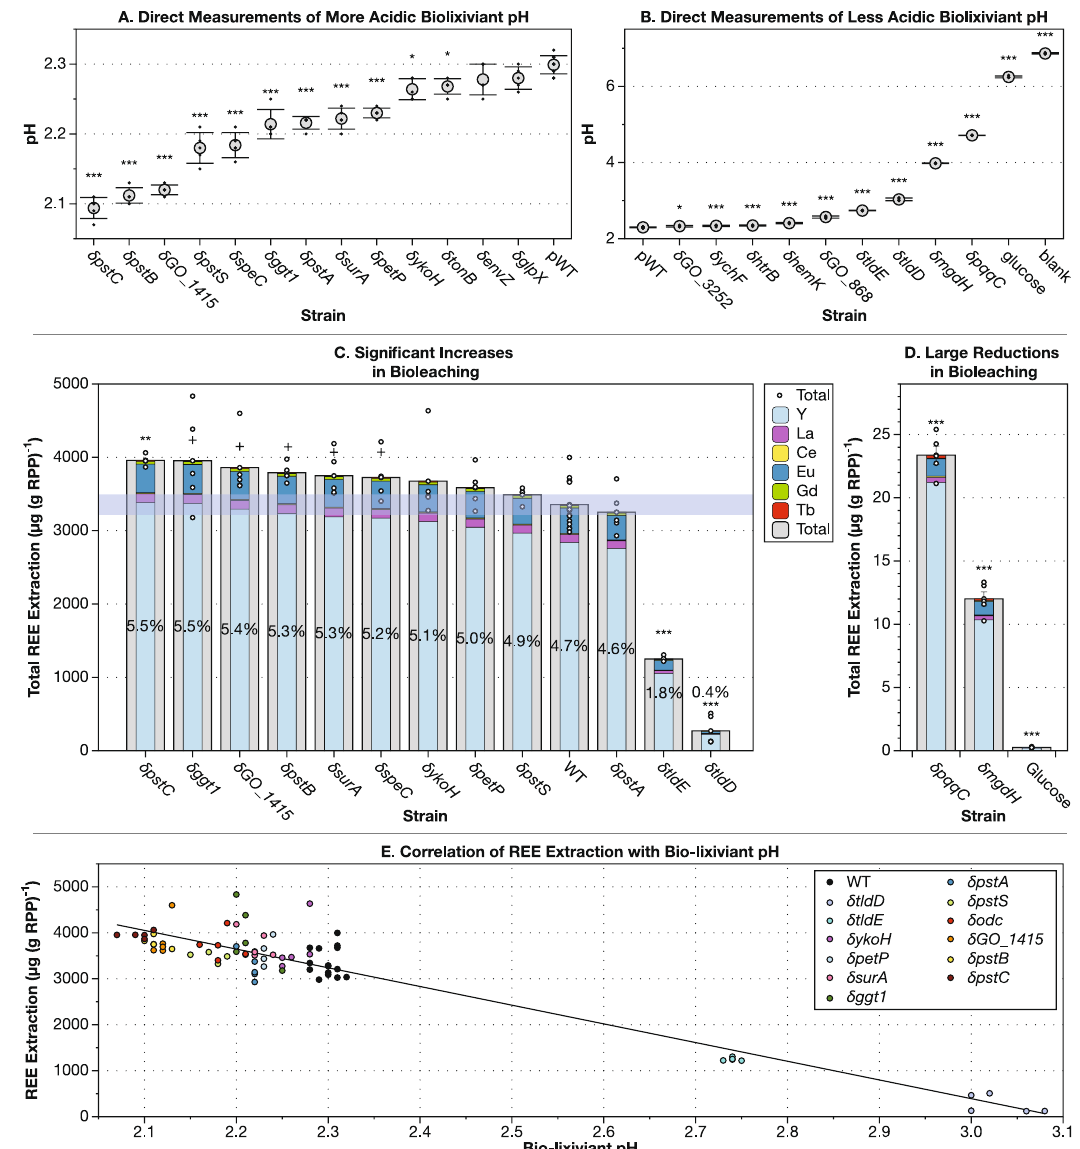
Fig. 4 Increased acidi fi cation strains of G. oxydans B58 are able to increase rare earth extraction from retorted phosphor powder (RPP). A , B A subset of 22 disruption strains was tested for acidi fi cation with direct pH measurement. Gray circles represent the mean pH for each strain and comparisons were made with wild type by two-tailed t- test with Bonferonni correction ( N = 22). pH measurements signi fi cantly different from pWT are labeled with asterisks: * p